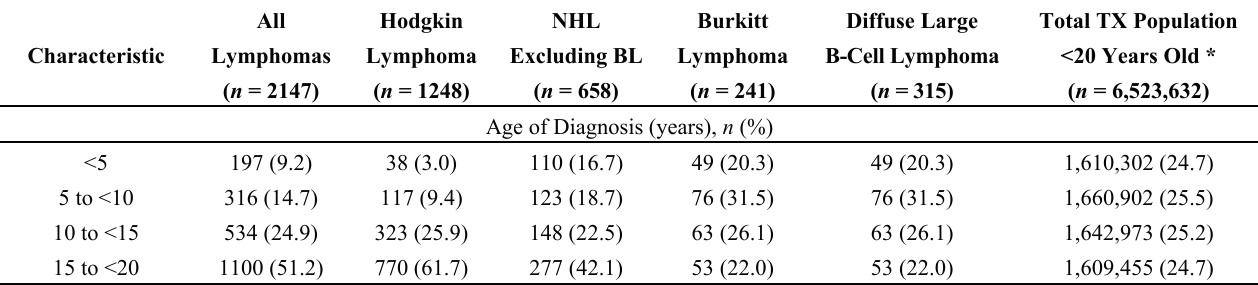
Table 2. Demographic characteristics of lymphoma malignancy subtypes among children and adolescents <20 years of age diagnosed in Texas,